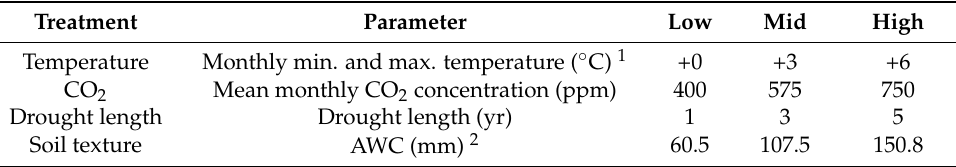
Table 2. Levels of the experimental treatment